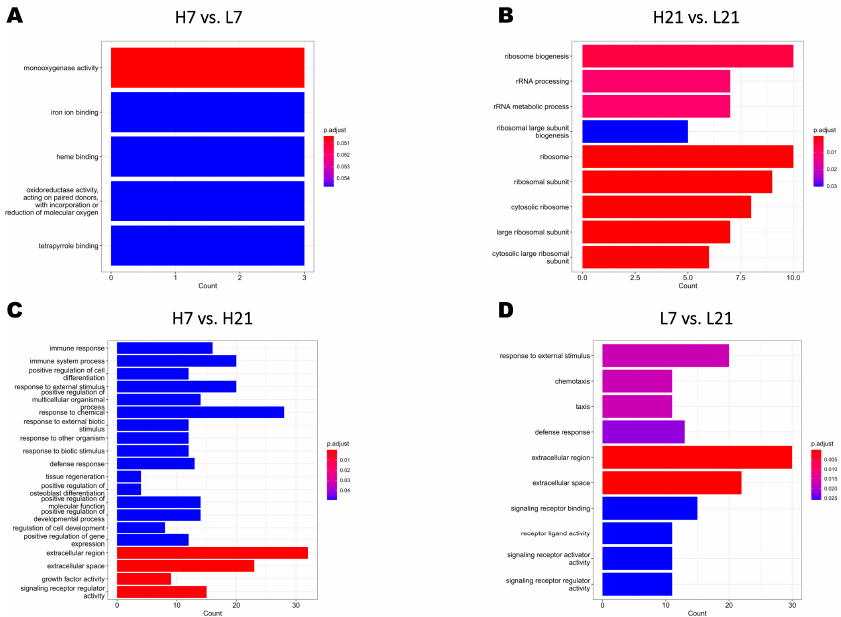
Figure 3. Identification of Gene Ontology (GO) terms of different groups. ( A ) H7 vs. L7 GO terms. ( B ) H21 vs. L21 GO terms. ( C ) H7 vs. H21 GO terms. ( D ) L7 vs. L21 GO terms. H7: High H/L SE-infected 7 dpi (n = 6); L7: Low H/L SE-infected 7 dpi (n = 7); H21: high H/L SE-infected 21 dpi (n = 5); L21: Low H/L SE-infected 21 dpi (n =